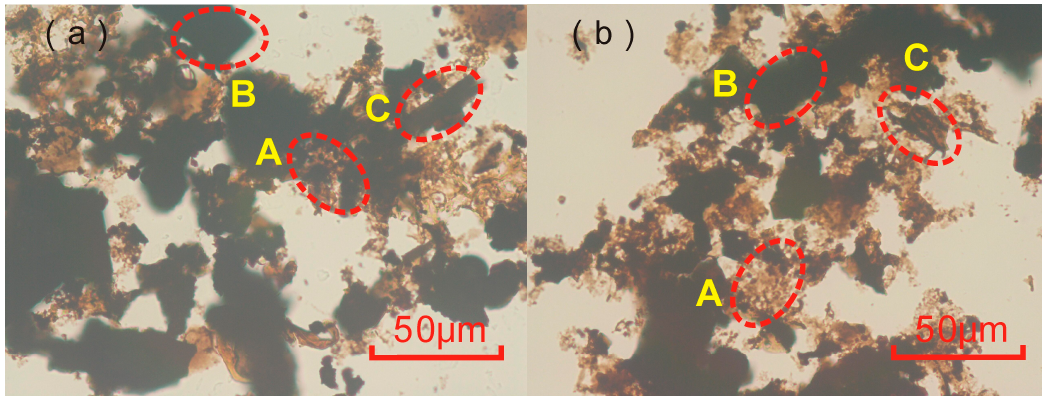
Figure 3. Macerals of transitional Longtan Shale samples from YV-1 ( a ) and XD-1 ( b ). A is brown dispersed sapropelic component; B is black inertinite; C is brown strip vitrinite.